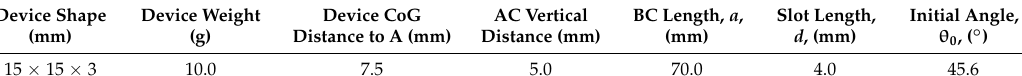
Table 3. Main system features.